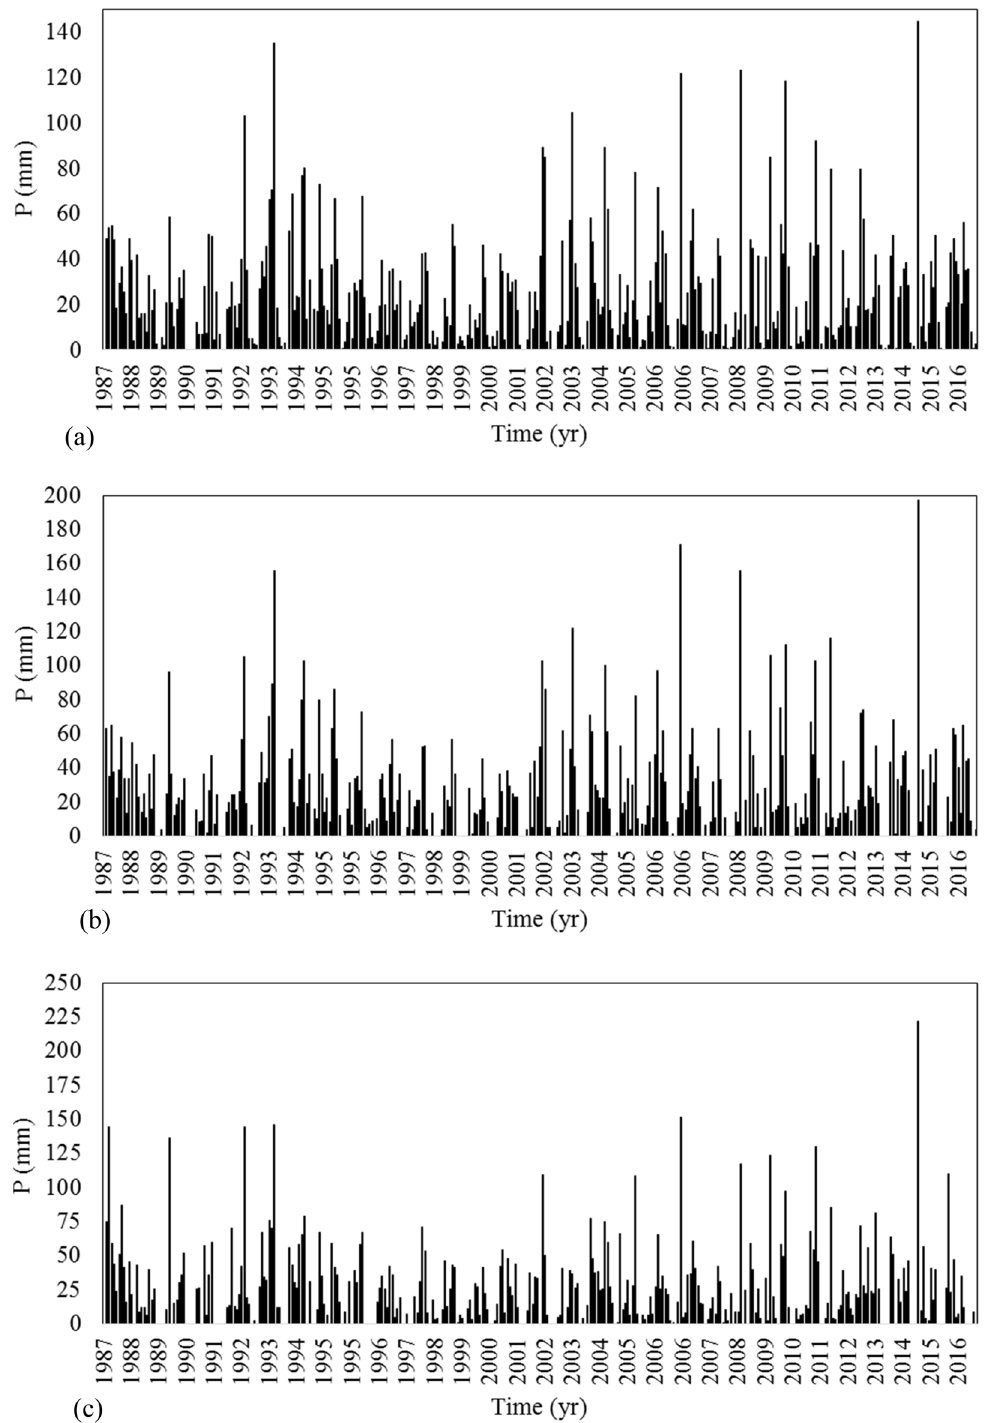
Figure 3. Hyetograph of precipitation in ( a ) Salmas, ( b ) Roshandeh, and ( c ) Up-Zolachai